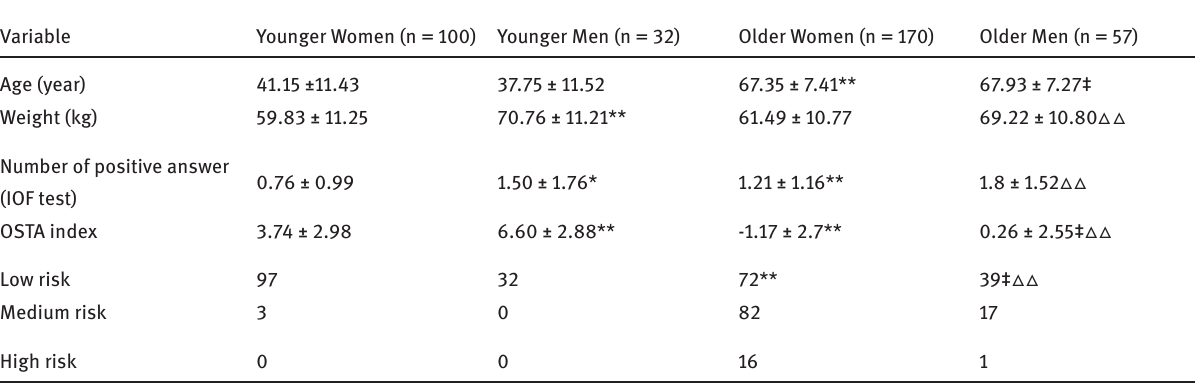
Table 1: Comparision of Clinical Features in Different Groups